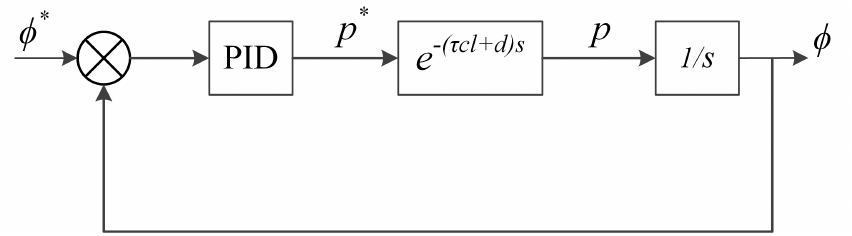
Figure 12. Roll attitude control system of the multirotor having estimated inner loop dynamics.